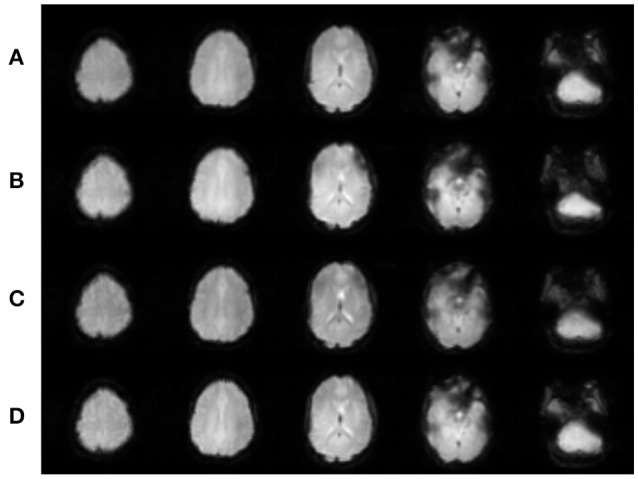
Realigned images for each EPI sequence for one participant. (A) SHORT, TR = 700 ms; (B) AVG2, TReffective = 1400 ms; (C) AVG4, TReffective = 2800 ms; (D) REF, TR = 1440 ms. Slices were created using Mango (http://ric.uthscsa.edu/mango/; Jack L. Lancaster and Michael J. Martinez).